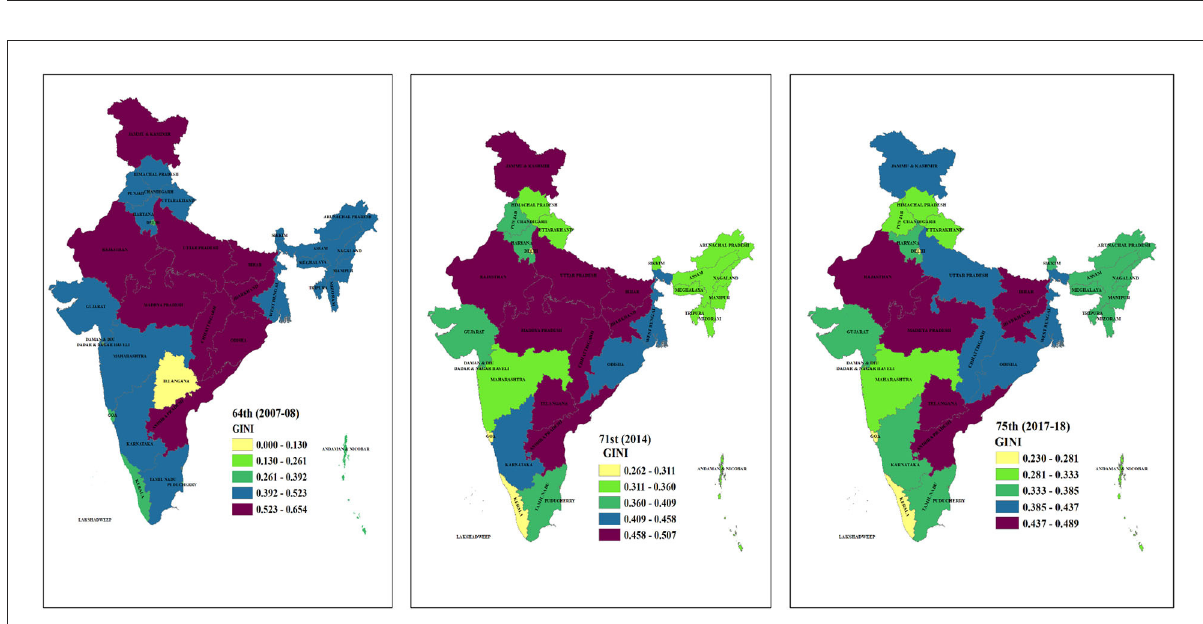
FIGURE2 Education Gini by state/UTs. Note: 1. Telangana state is formed in the year 2014, so data are not available for the 64th round. 2. North-Eastern includes: Assam, Arunachala Pradesh, Sikkim, Meghalaya, Manipur, Mizoram, Tripura, and